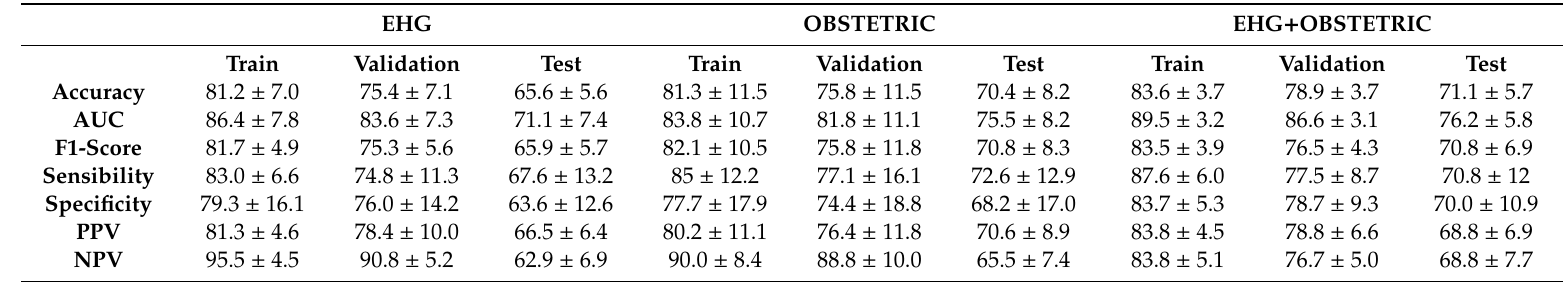
Table 5. Mean and SD of model performance indicators in predicting labor in under or over 14 days using EHG characteristics, obstetric data or a combination of both. PPV: predictive positive value; NPV: predictive negative value. EHG